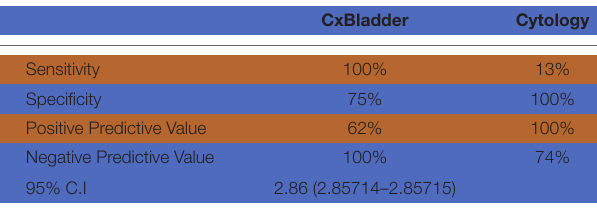
TABLE 2 | CxBladder vs. urine cytology for bladder cancer cases. CxBladder